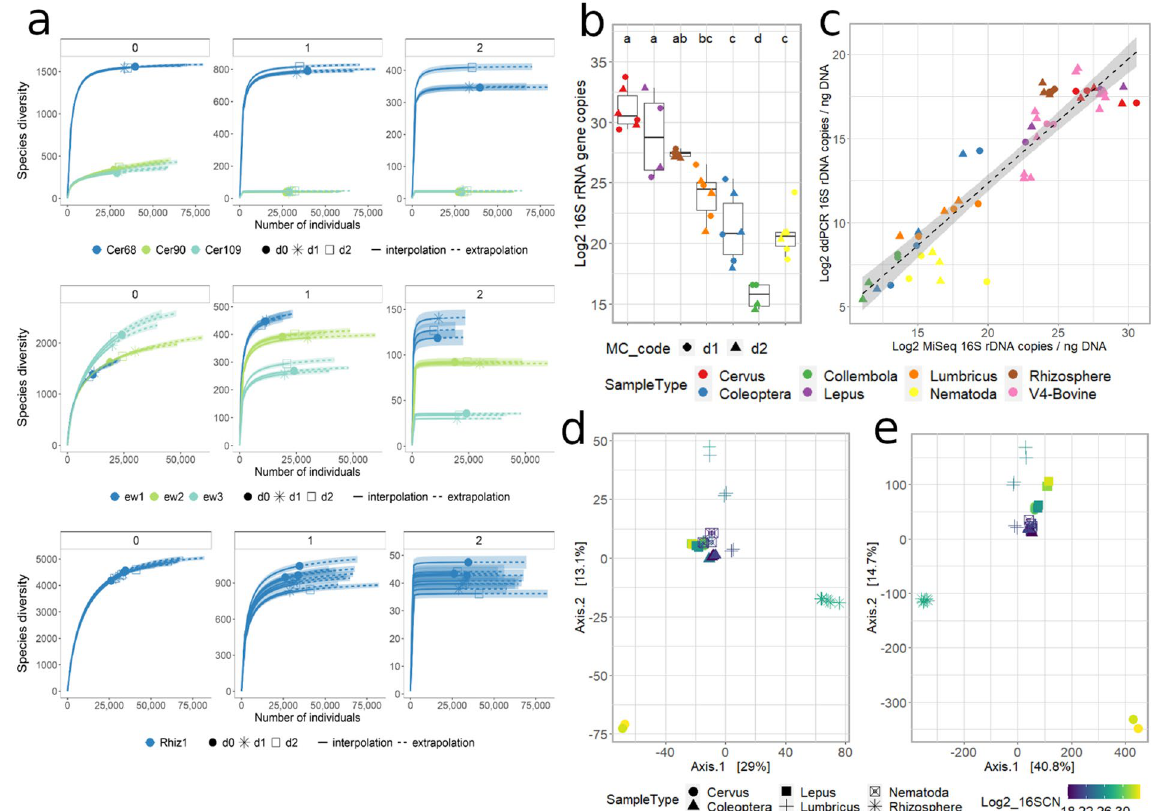
Figure 5. Diversity estimates and 16S rRNA copy number for test samples. ( a ) Sample-size-based rarefaction (solid lines) and extrapolation (dotted lines) sampling curves with 95% confidence intervals (shaded areas; based on a bootstrap method with 200 replications) separated by the diversity order [q]: q = 0 (species richness, left panel), q = 1 (Shannon diversity, middle panel) and q = 2 (Simpson diversity, right panel) for C. elaphus (upper plots), Lumbricus spp. (center plots), Carex spp. rhizosphere soil (bottom plots). MC doses are expressed as d0 (no MC added to the sample), d1: higher dose and d2: lower dose (please refer to Table 3 for additional details on MC doses for each sample type). ( b ) Log 2 16S rRNA gene copies estimated from the abundance of I. halotolerans -related SVs in the same library. ( c ) correlation between 16S rRNA gene copies estimated by ddPCR (y axis) and miSeq (x axis). The dotted line shows the corresponding linear regression line with 95% confidence interval (grey area). ( d – e ) Beta diversity estimates of test samples. PCAs were generated by using Euclidean distance on CLR normalized datasets. ( d – e) plots were generated by using untransformed SV counts ( d ) and SV counts transformed according to the abundance of MC-related reads ( e